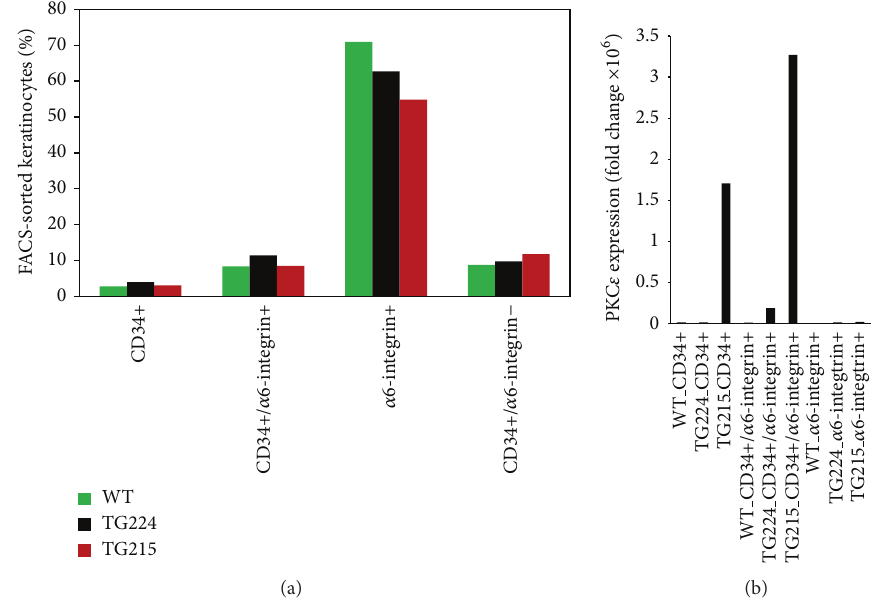
Figure 6: Distribution and expression of PKC 𝜀 in FACS-sorted keratinocytes from WT, TG224, and TG215 mice. (a) FACS-sorted keratinocytes. The keratinocytes were harvested from 5 weeks old wild-type and TG mice and incubated with the CD34 and 𝛼 6-integrin florescent antibodies. After labeling, the cells were washed twice, filtered, and sorted for CD34+, 𝛼 6-integrin+ cells, CD34+/ 𝛼 6-integrin+, and CD34 − / 𝛼 6-integrin-cells. (b) PKC 𝜀 expression. The RNA was isolated from the sorted cell, followed by cDNA preparation, and then real- time PCR using SYBR Green double-strand DNA binding dye. After real-time PCR Ct values were calculated and analyzed for expression. All the expression values shown in the figures are relative to their mouse Gapdh internal